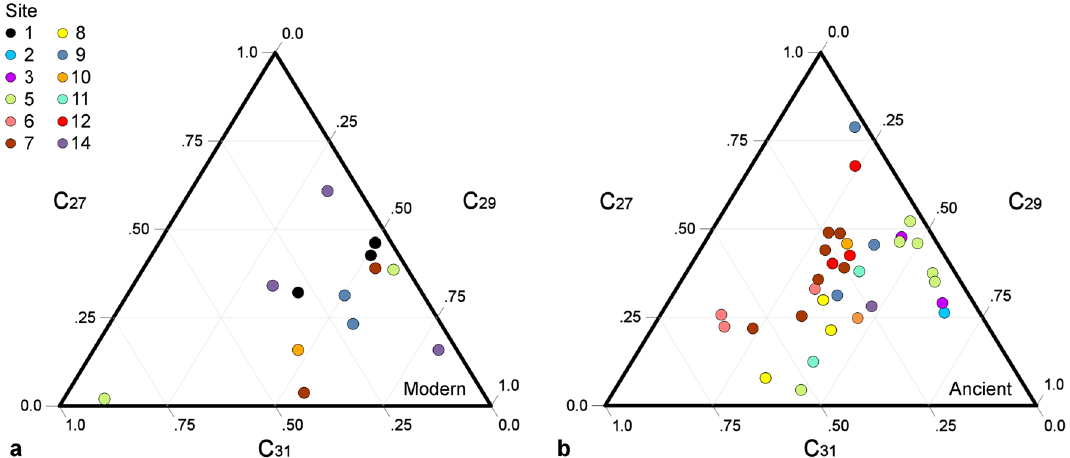
Figure 6. Ternary diagrams of the C 27 , C 29 , and C 31 n -alkanes. ( a ) Relative abundances of each n -alkane compound for a. modern P. australis and b. ancient Great Wall Phragmites . Site number corresponds to locations and color scheme in Fig.